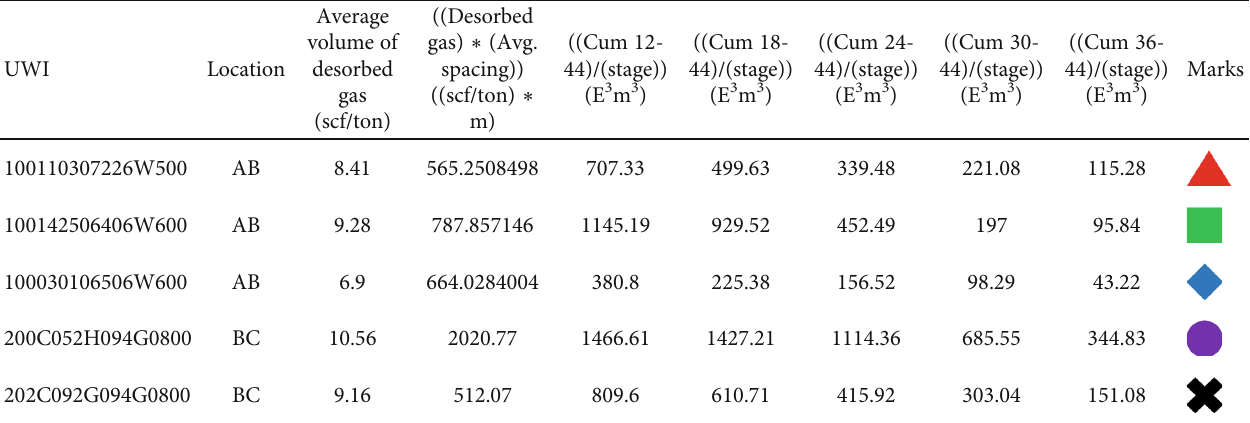
Table 5: Estimated desorbed gas volume and sum of gas production by month were modi fi ed to fi gure out the gas production amount by stage count and average stage spacing